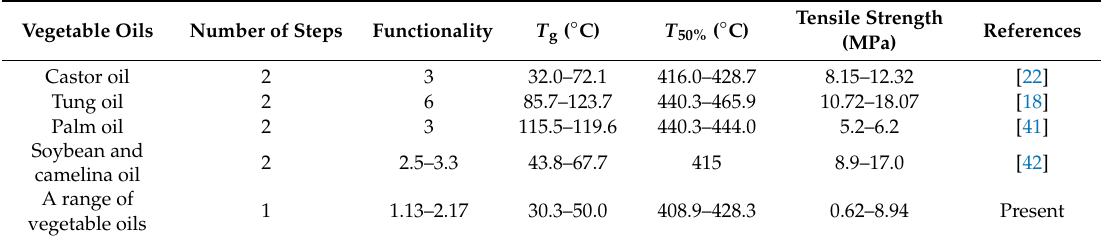
Table 5. Comparison of the vegetable oil-based UV-curable prepolymers and the properties of the resultant cured